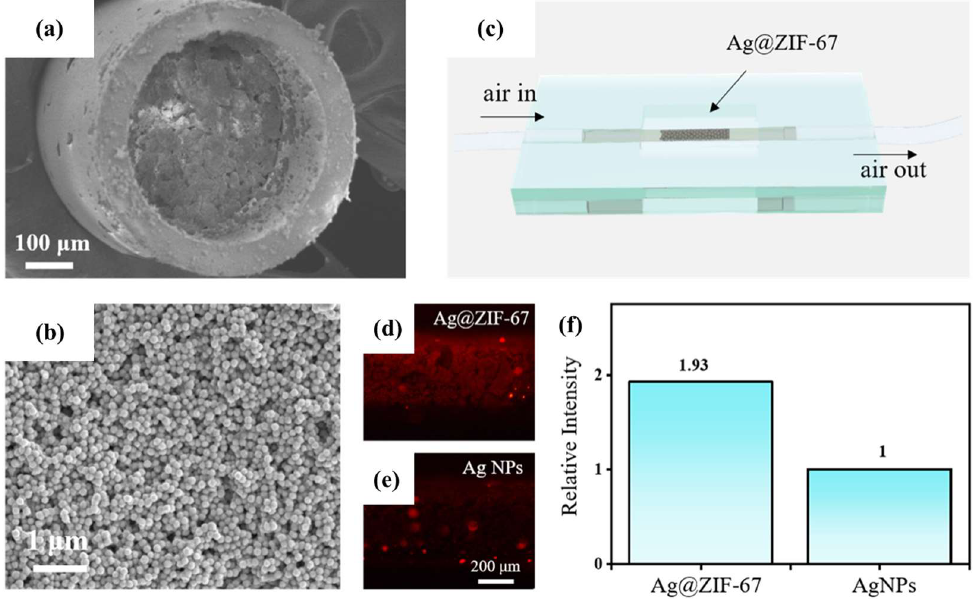
Figure 13. Tubular SERS gas sensor. ( a ) SEM image of the cross-section of the capillary tube loaded with Ag@ZIF-67/4-ATP powder and ( b ) high magnification SEM image of the particle clusters. ( c ) Schematic diagram of the sensing device with the glass capillary loaded with Ag@ZIF-67/4-ATP nanoparticles and fixed in a resin channel, which was connected with two tubes at the ends of the capillary. ( d , e ) Fluorescence microscopy images for the capillary filled with ( d ) Ag@ZIF-67/4-ATP and ( e ) Ag/4-ATP nanoparticles upon the absorption of fluorescent gas molecules. ( f ) Relative fluorescent intensity obtained from the above fluorescence images ( d , e ) processed by ImageJ to show the difference in absorbed fluorescent gas molecules between the tube sensor filled with Ag@ZIF- 67/4-ATP and AgNPs/4-ATP nanoparticles, respectively (Reprinted with permission from Ref. [135]. Copyright 2022, American Chemical Society).